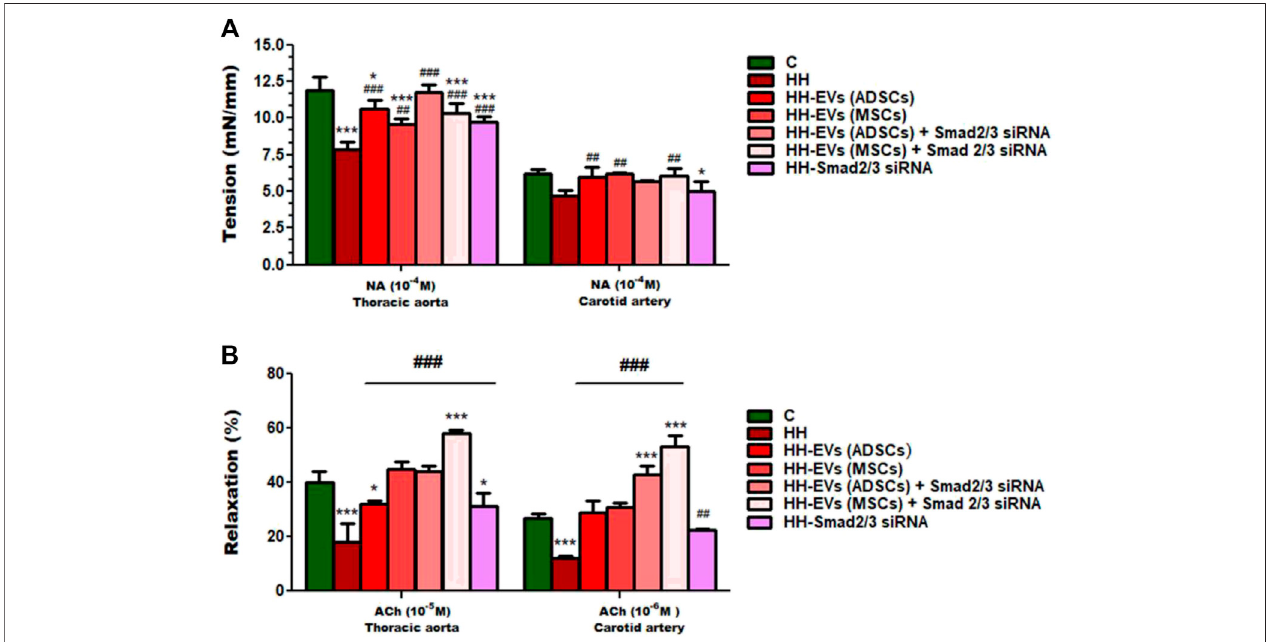
FIGURE 7 | Measures of vascular reactivity of the thoracic aorta (left) and carotid artery (right) explanted from all hamster groups (C, HH, HH-EVs(ADSCs), HH- EVs(MSCs),HH-EVs(ADSCs)+Smad2/3siRNA,HH-EVs(MSCs)+Smad2/3siRNA,andHH-Smad2/3siRNA)byusingthemyographtechnique,intermsof (A) contraction to NA and (B) relaxation to ACh. Maximal contractile force developed by the thoracic aorta and carotid artery was measured to be 10 − 4 M NA, and maximal relaxation valueswererecordedtobe10 − 5 MAChforthethoracicaortaand10 − 6 MAChforthecarotidartery.Dataaremean±SDoffourindependentexperimentsforeach investigatedtreatedgroupand fi veindependentexperimentsforcontrolandHHgroups.Thestatisticalsigni fi cance,noticeablydifferent,wasrepresentedas*** p < 0.005 and * p < 0.05 versus control group and ### p < 0.005 and ## p < 0.01 versus HH group. The values were calculated by two-way ANOVA and Bonferroni post-test. EnhancedplasmaTGF- β